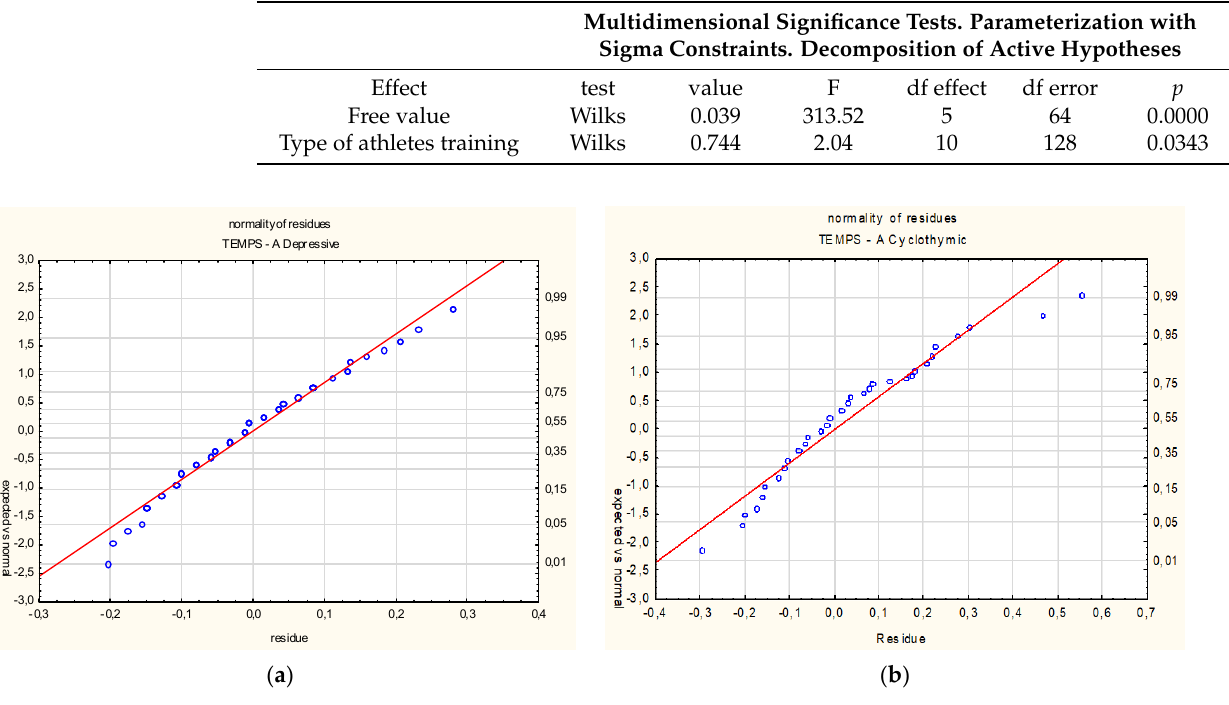
( d ) ( e ) Figure 2. The diagram of normality of residues of affective temperaments dimensions: ( a ) depressive, ( b ) cyclothymic, ( c ) hyperthymic, ( d ) irritable and ( e ) anxious.